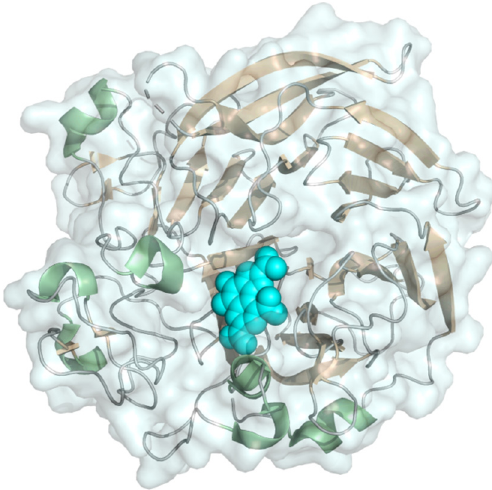
Figure 8. Crystal structure of Acinetobacter calcoaceticus PQQ-dependent glucose dehydrogenase (PDB: 5MIN) with the PQQ cofactor (cyan spheres) rather exposed to the protein surface.